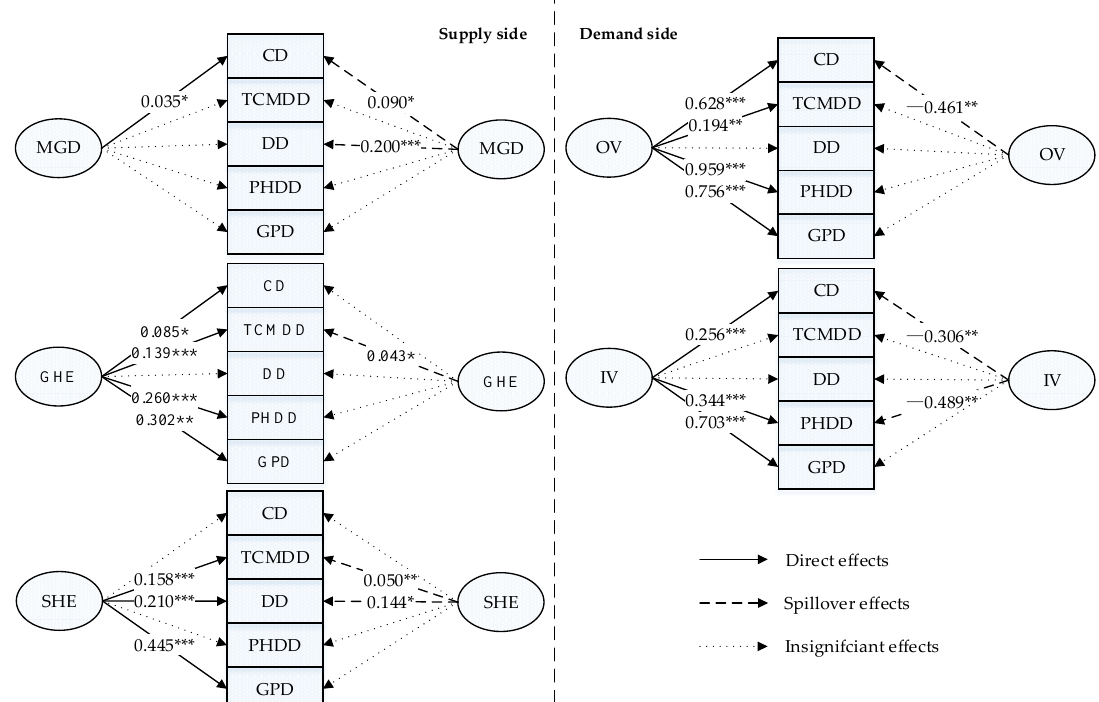
Figure 4. Summary of direct and spillover effects of supply-side and demand-side factors on the densities of different subtypes of licensed doctors. Note: *** p < 0.01, ** p < 0.05, * p < 0.1 . CD = Clinician density, TCMDD =